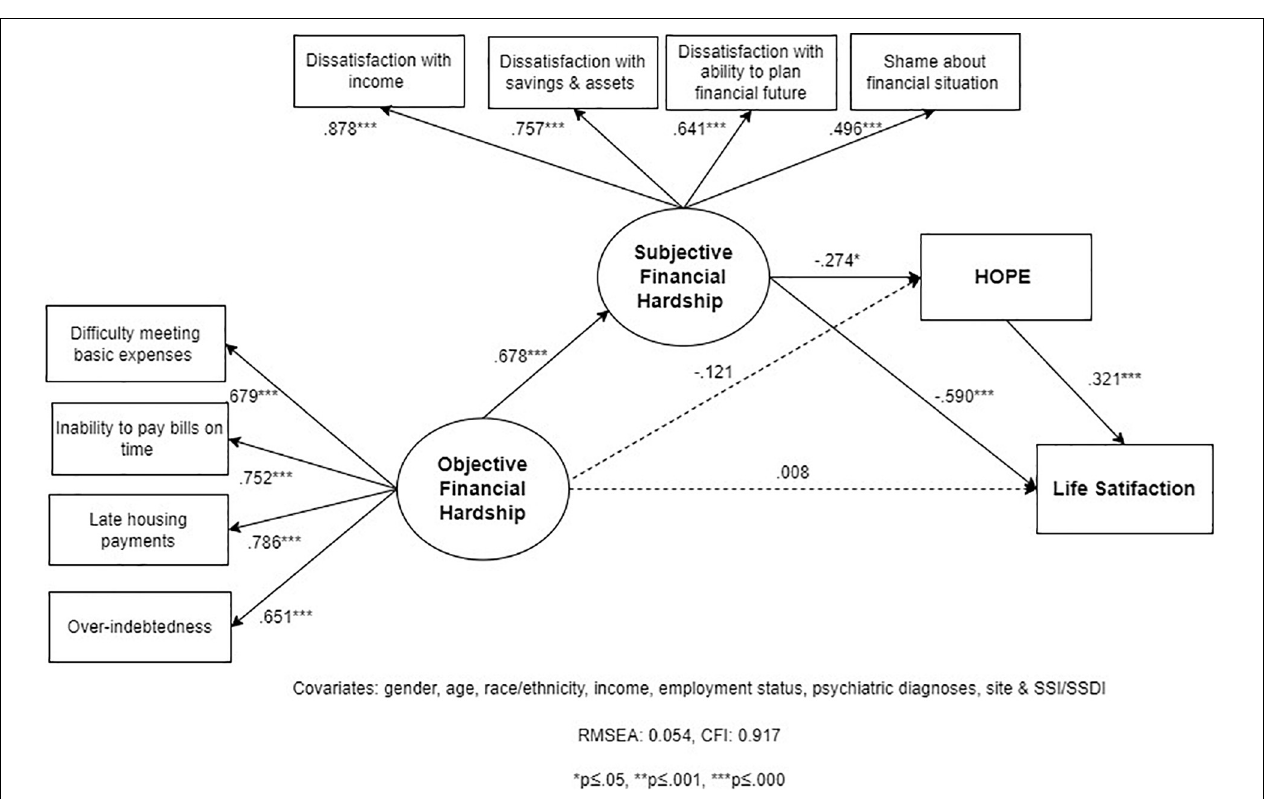
FIGURE 3 | Structural Equation Model 2 (SEM 2): relationship between objective financial hardship (OFH), subjective financial hardship (SFH), hope, and life satisfaction (LS; N = 202).